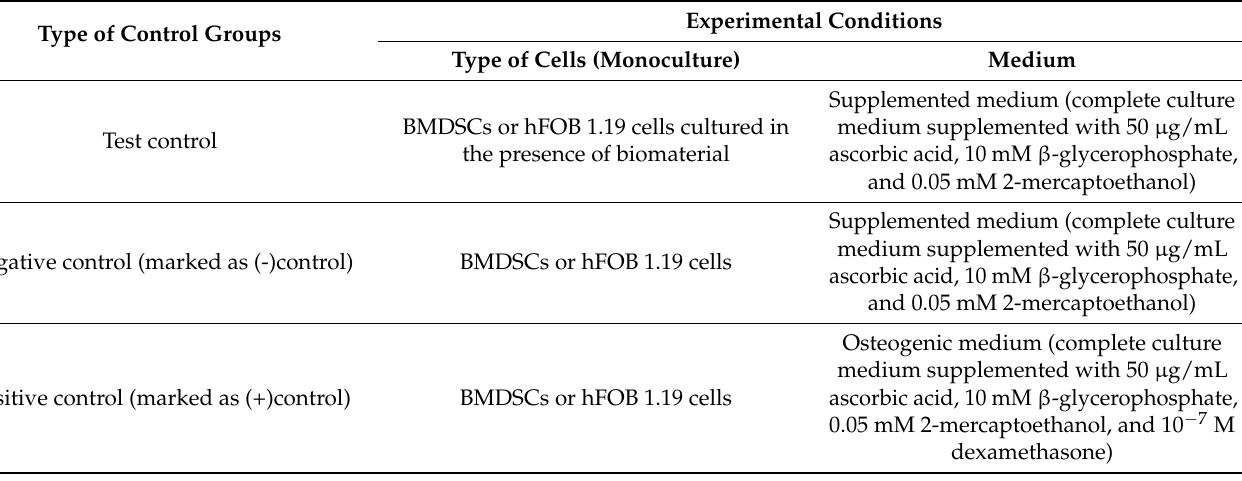
Table 2. Experimental conditions of control groups used in the co-culture